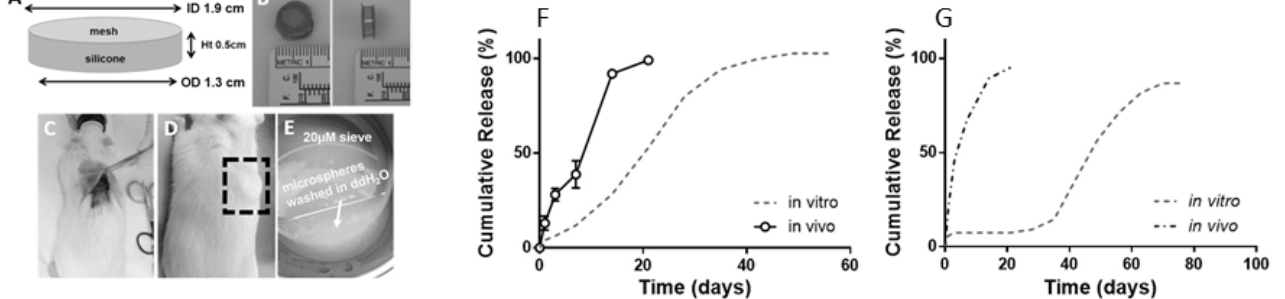
Figure 5. ( A ) Dimensions of a cage implant. ( B ) Top and side view of the silicone rubber/stainless cage implant. ( C , D ) Cage that is subcutaneously implanted in a rat ( E ) Retrieved cage prior to analysis